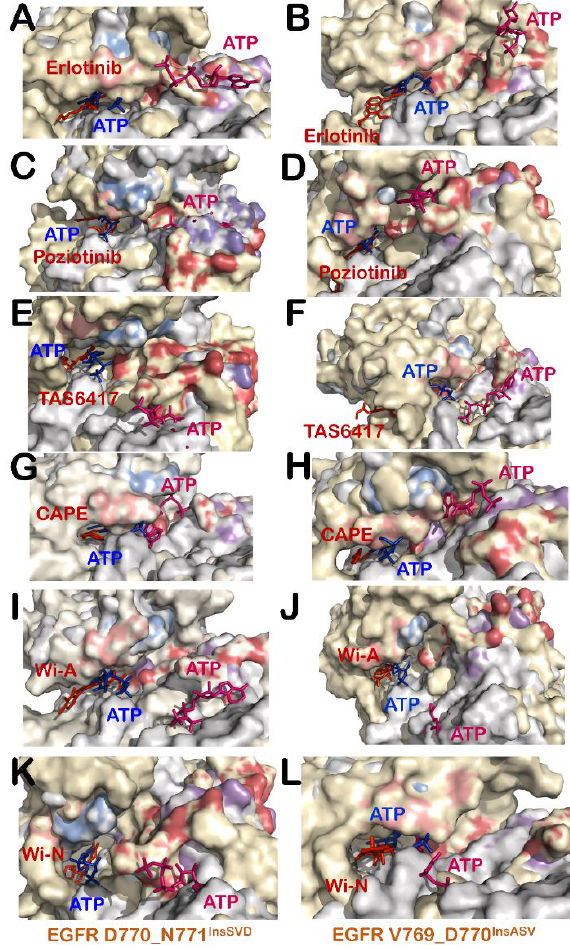
Figure 3. Superimposition of wildtype EGFR – ATP (grey-blue) complex with D770_N771 InsSVD - inhibitor – ATP (yellow-red-pink) complexes ( A , C , E , G , I , K ) and V769_D770 InsASV -inhibitor – ATP (yellow-red-pink) complexes ( B , D , F , H , J , L ) showing interaction of ATP and inhibitors at the ATP binding site: erlotinib ( A , B ); poziotinib ( C , D ); TAS6417 ( E , F ); CAPE ( G , H ); Wi-A ( I , J ); and Wi-N ( K , L ). P Loop and activation segment of wildtype EGFR – ATP complex is shown in marine blue and purple color and that of EGFR exon 20 insertion mutant – inhibitors – ATP complexes is shown in salmon and firebrick red color.